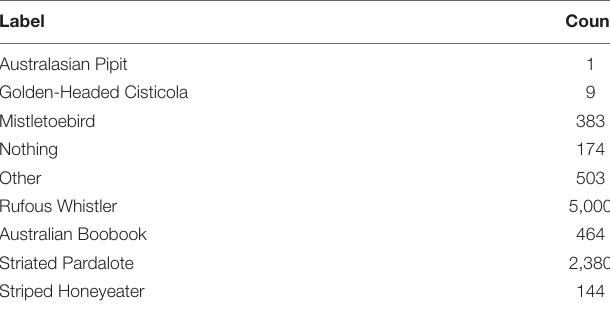
TABLE 1 | Number of initial recordings from other